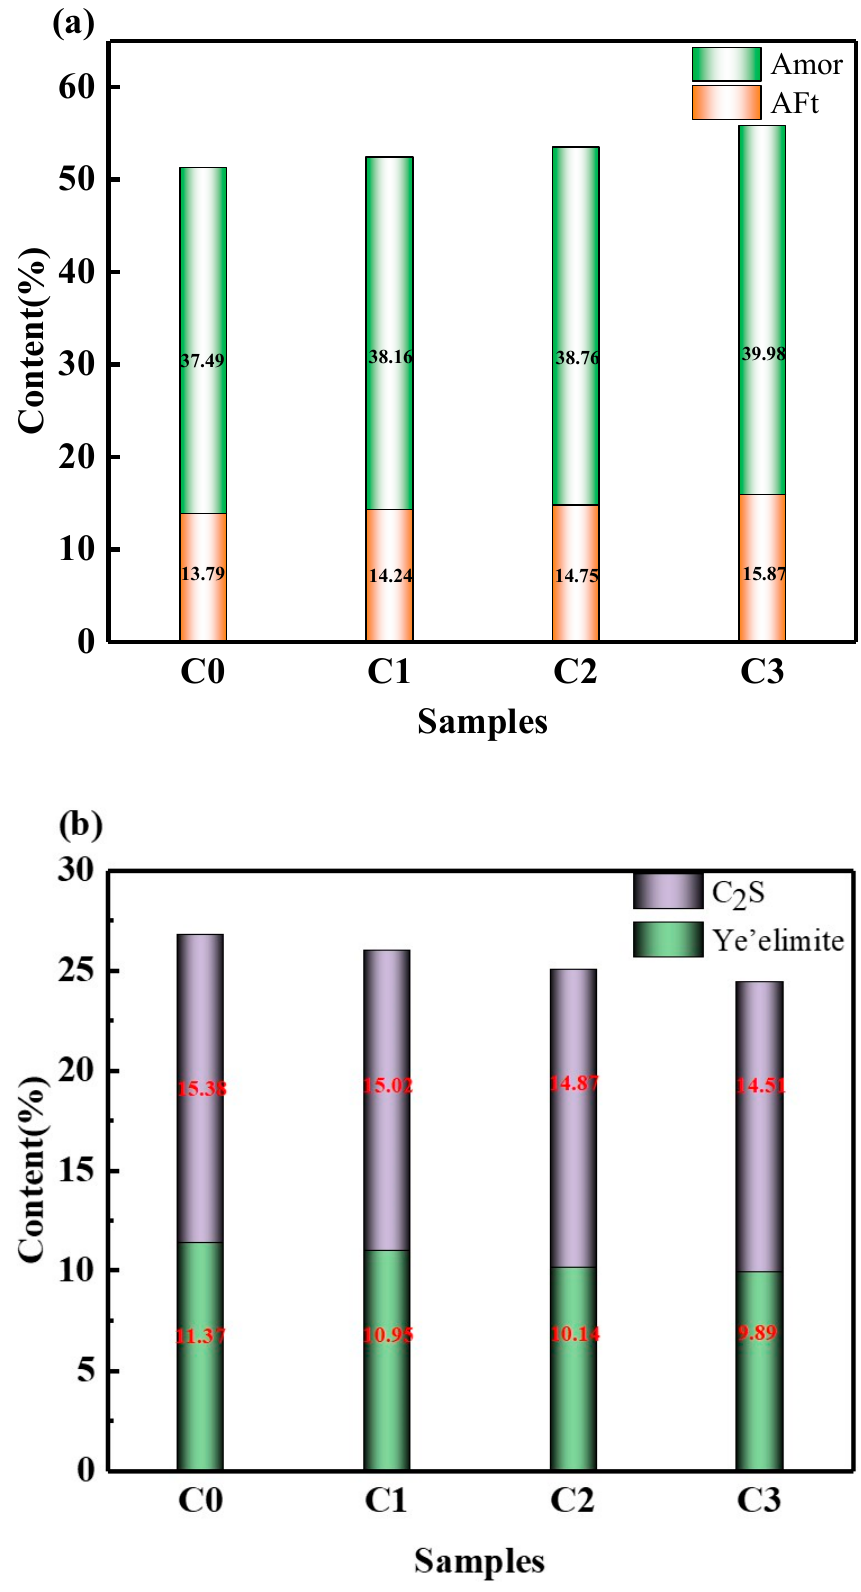
Figure 8. Contents of hydration products and unhydrated clinker ( a , b ).